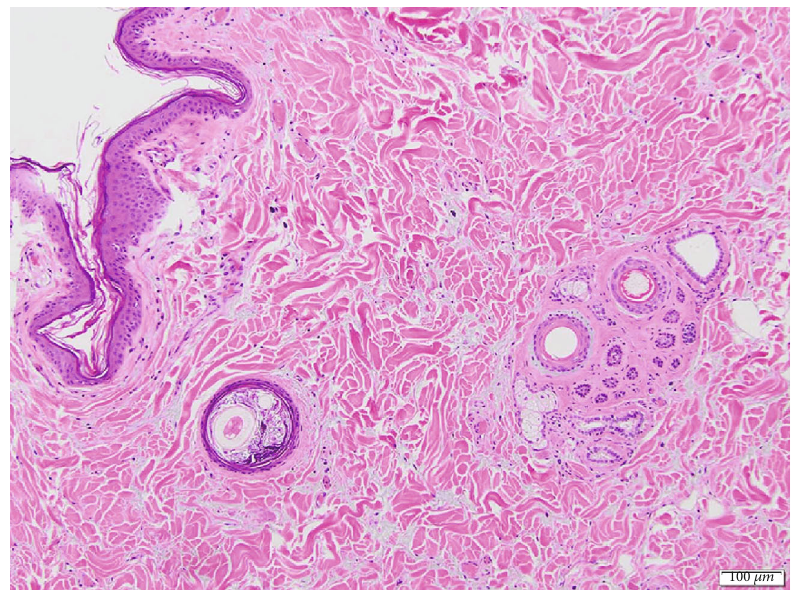
Figure 4: Histopathology of haired skin (hematoxylin and eosin stain, 10x). There is epidermal and adnexal atrophy. Dermal collagen layers are separated by white space (edema) with intervening amorphous amphophilic to basophilic material (mucinosis), changes supportive of cutaneous myxedema.